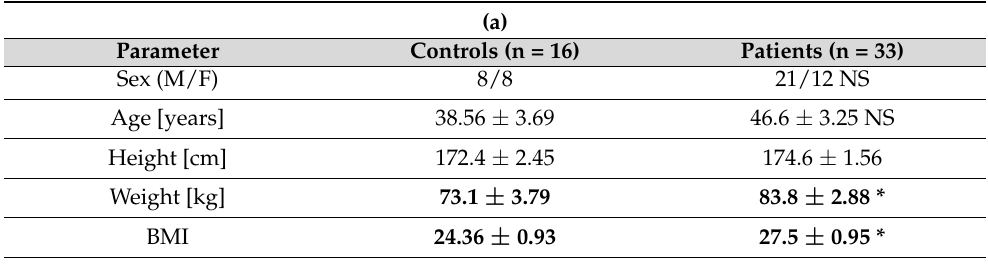
Table 1. Baseline characteristics of patients and